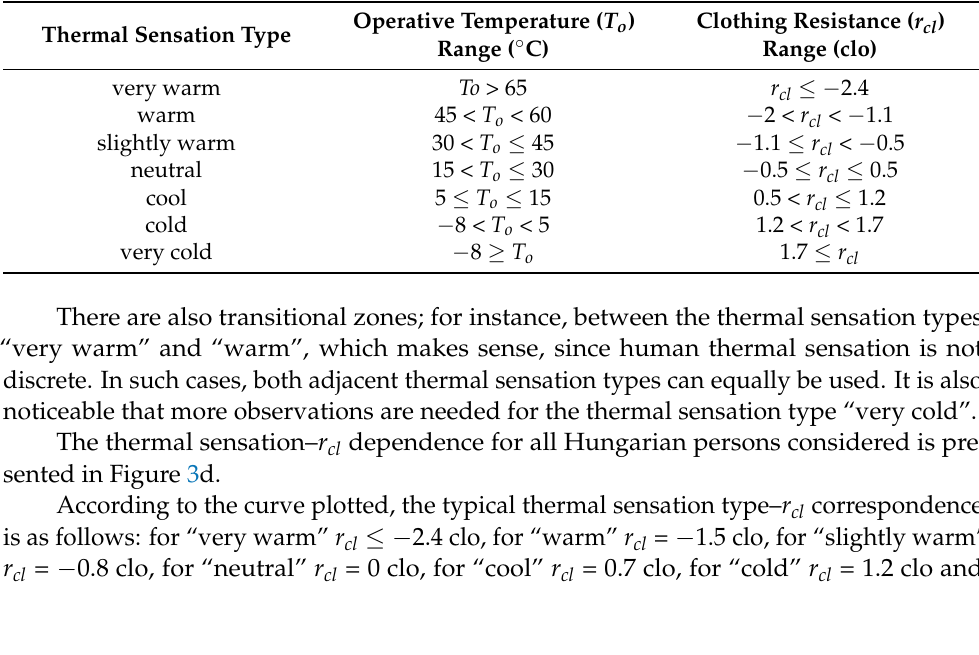
Table 3. Operative temperature and clothing resistance limits for different thermal sensation types obtained for 5 Hungarian